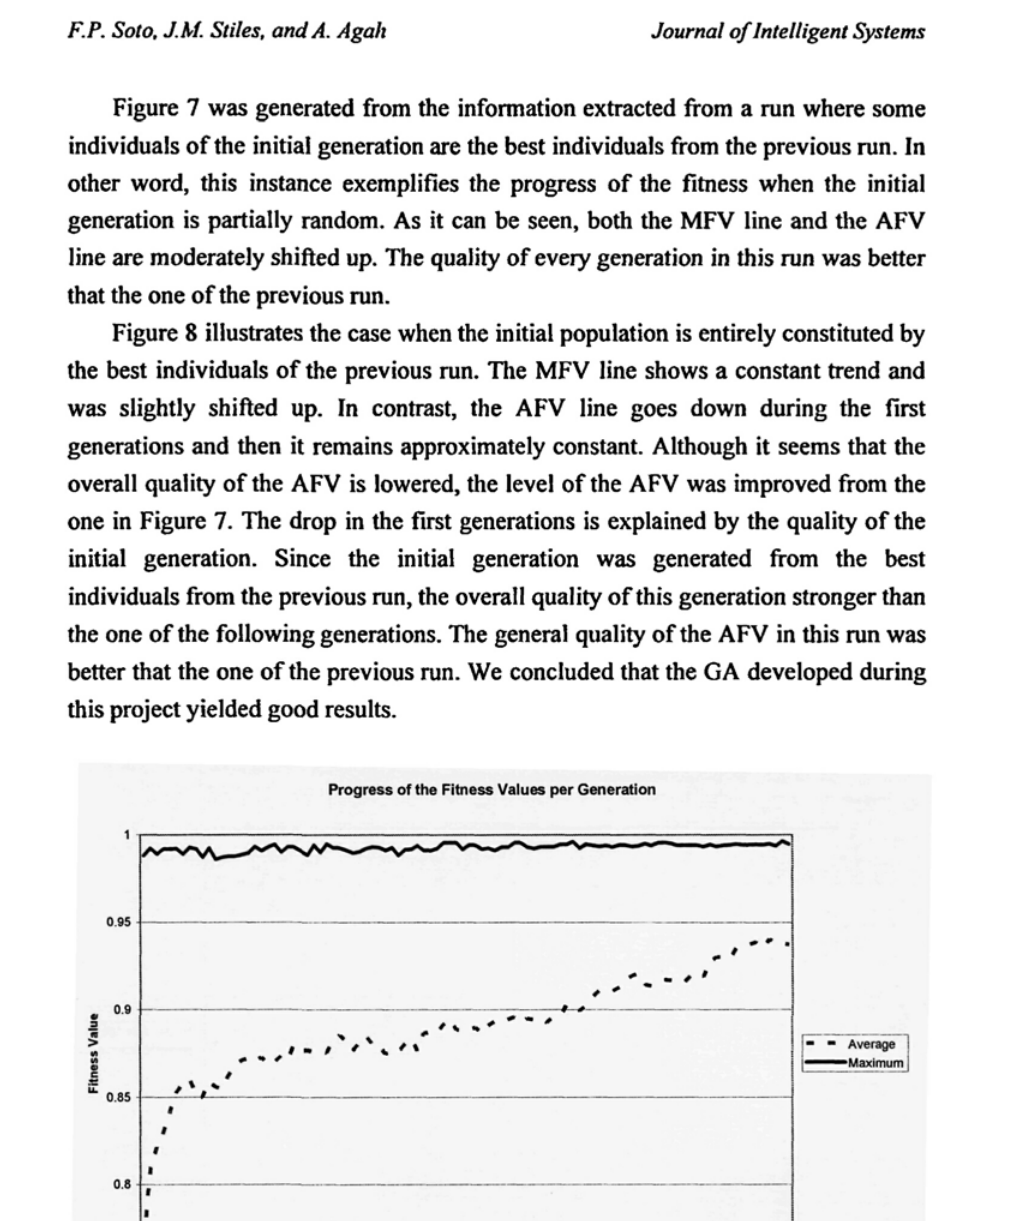
Fig. 6: The fitness value when the initial generation is totally